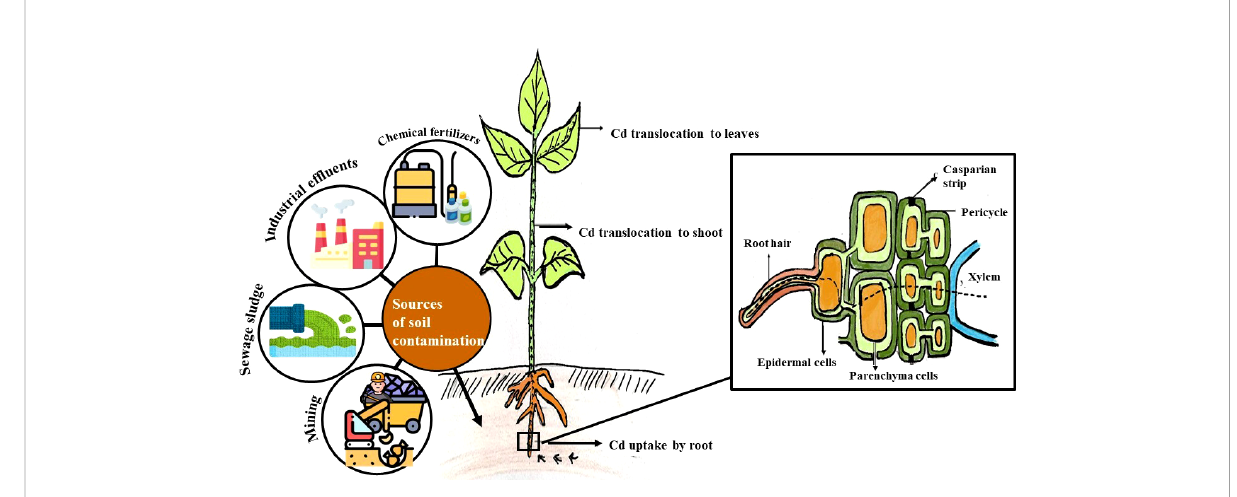
FIGURE 1 Source, uptake and translocation of cadmium from soil to root, shoot and leaves and mechanism underlying the mobilization of cadmium through root hairs to the xylem